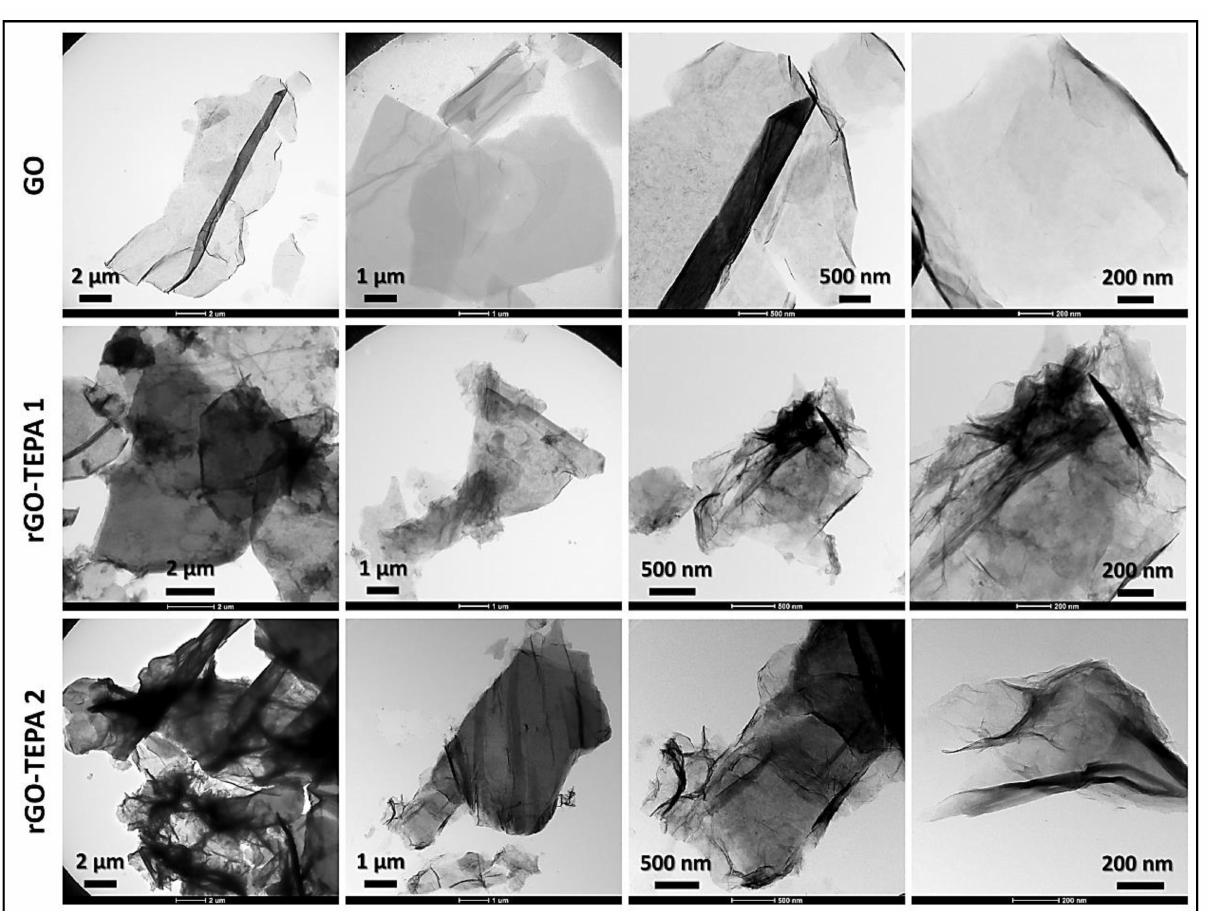
Figure 7. TEM images of the pristine GO, rGO-TEPA1 and